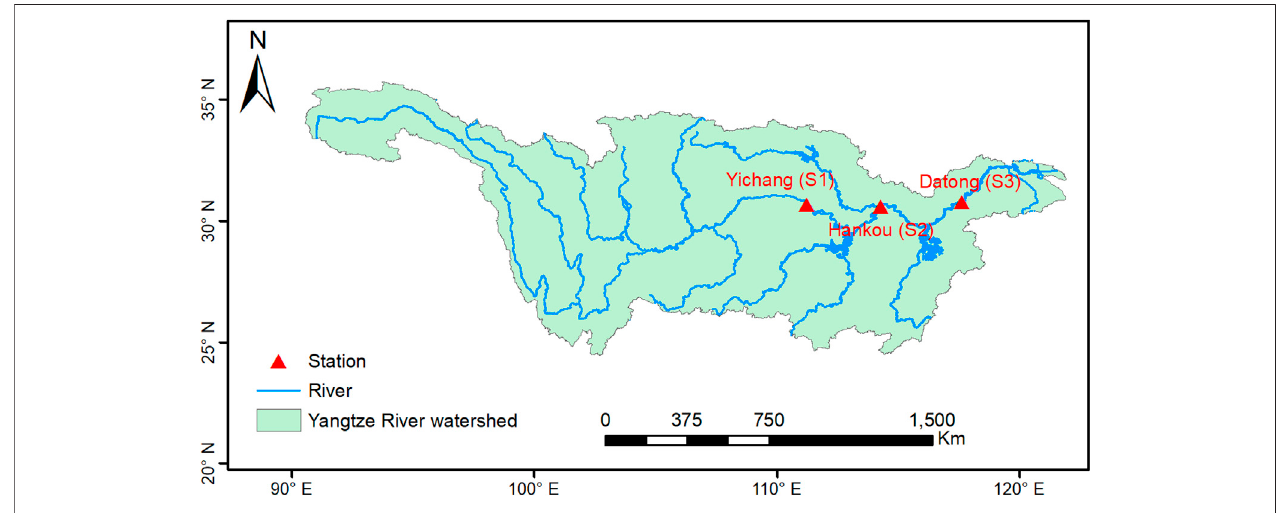
FIGURE 2 | The Yangtze River